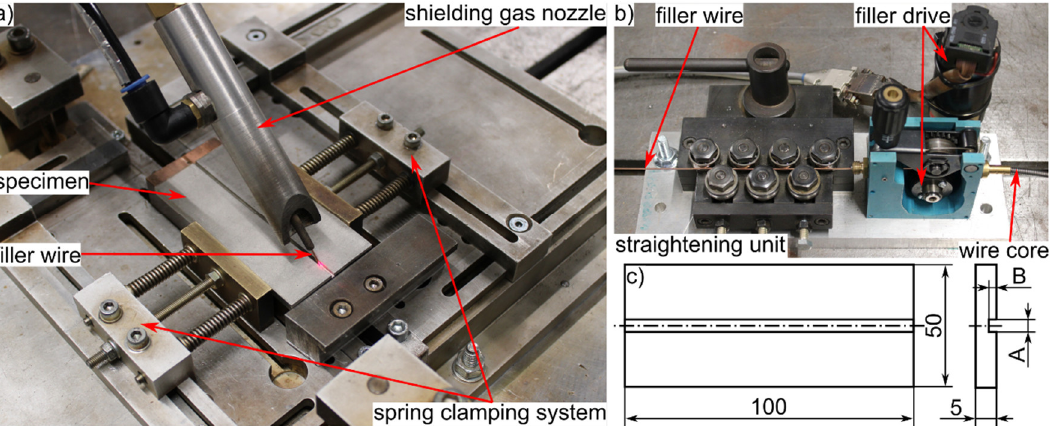
Figure 1. Welding setup. ( a ) Clamping setup with wire-feeding system; ( b ) miniDrive with a straightening unit for the filler wire; ( c ) sketch of the welding specimen with rectangular seam preparation.